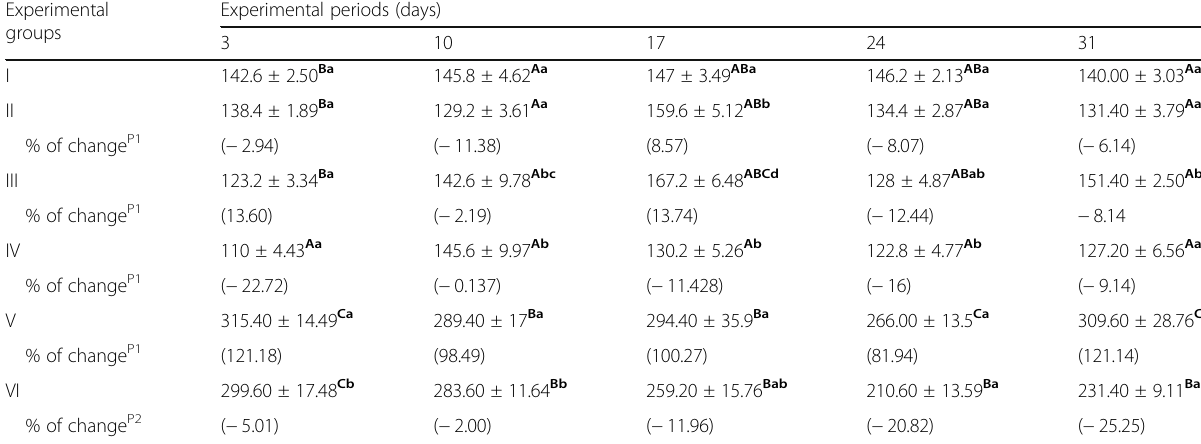
Table 1 Blood glucose levels (mg/dl) in the experimental groups at the experimental periods Experimental Experimental periods (days) groups